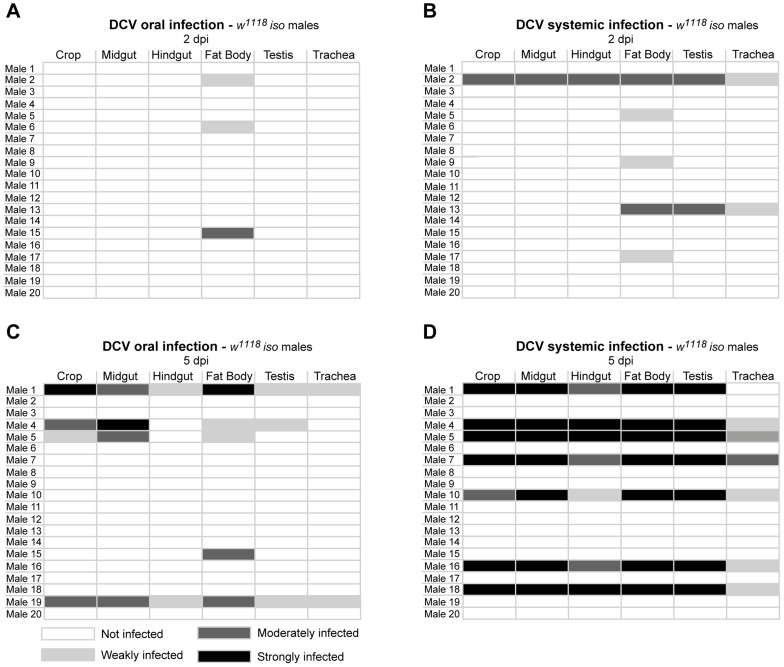
DCV oral and systemic infections have similar tissue tropism.(A and B) DCV tissue tropism 2 days after oral (A) and systemic (B) infection. (C and D) DCV tissue tropism 5 days after oral (C) and systemic (D) infection. DCV was at 1011 TCID50/ml for oral infection, 105 TCID50/ml for systemic infection. Tissues of twenty adult males per condition were dissected and immunostained with an antibody against DCV, actin marked with phalloidin and DNA marked TOTO3. Oesophagus, crop, proventriculus, midgut, Malpighian tubules, hindgut, testes, fat body, trachea and thorax skeletal muscle tissues of every individual was analysed for DCV presence and the intensity of the infection by confocal microscopy. “Not infected” - DCV not detected in any part of the tissue observed. “Weakly infected” - DCV was detected in less than one third of the tissue. “Moderately infected” - DCV was detected in one to two thirds of the tissue. “Strongly infected” - DCV was detected in more than two thirds of the tissue. DCV infections were performed in 3–6 days old flies.